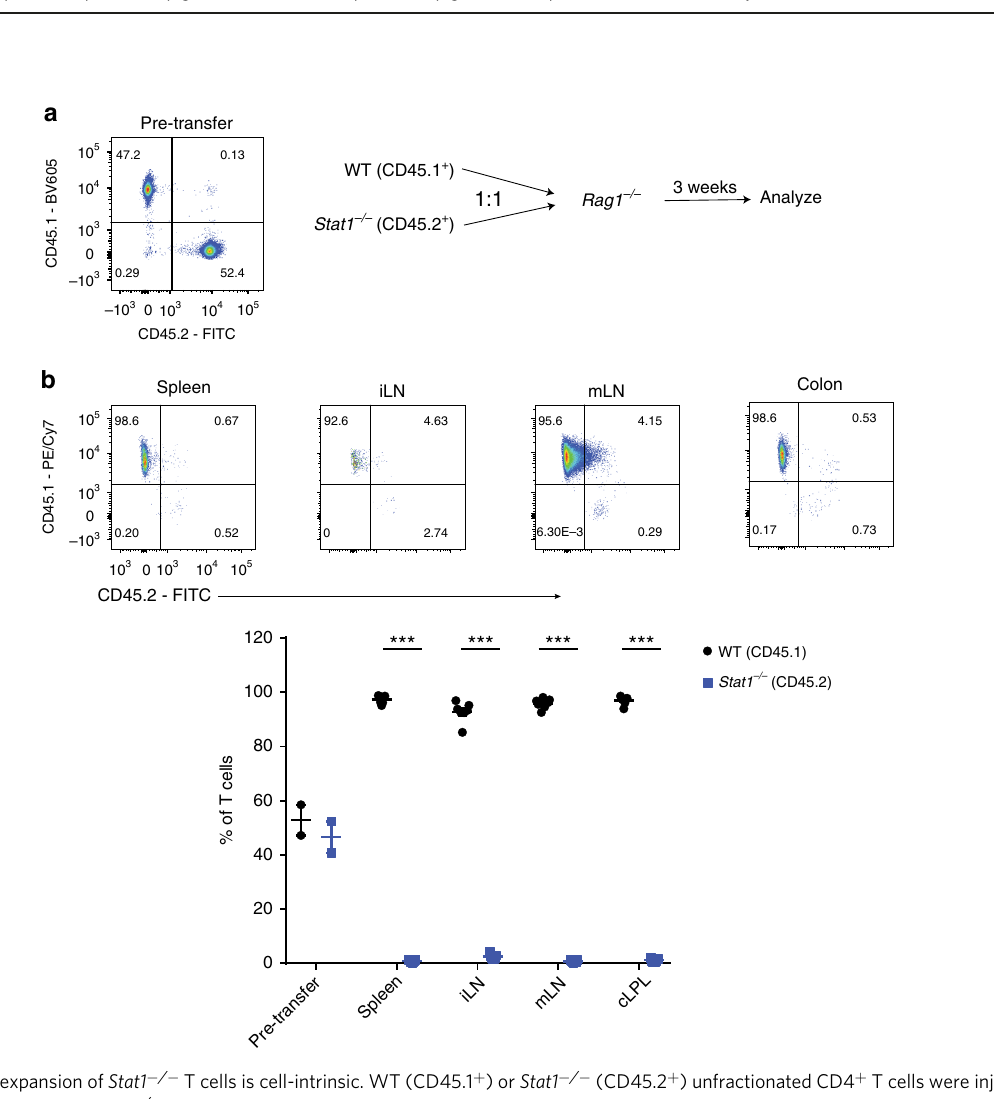
Fig. 3 Type I + II IFN signaling do not explain the defective expansion of Stat1 − / − T cells. Il10rb − / − Rag1 − / − mice were injected i.p. with 1 × 10 6 WT, Ifnar1 − / − Ifngr1 − / − or Stat1 − / − CD4 + T cells. a Representative fl ow cytometry plots of CD4 + T cells (gated on live CD45 + cells, Supplementary Fig. 4b) in the spleen and colon followed by their mean frequencies ± SEM at 3 weeks post transfer. b Mean % initial body weights ± SEM following T-cell transfer. Source data are provided as a Source Data fi le. c Representative images of colons, as well as representative H&E images of distal colon sections with mean histological scores ± SEM at 3 weeks post transfer. Scale bar represents 200 µ m. d Representative fl ow cytometry plots of CD4 + T cells (gated on CD45 + cells) in the blood followed by their mean frequencies ± SEM at 2 and 3 weeks post transfer. All data are pooled from two to three independent experiments, with each point representing an individual mouse. * p < 0.05, ** p < 0.01, *** p < 0.001, **** p < 0.0001 by b two-way ANOVA with Bonferroni ’ s